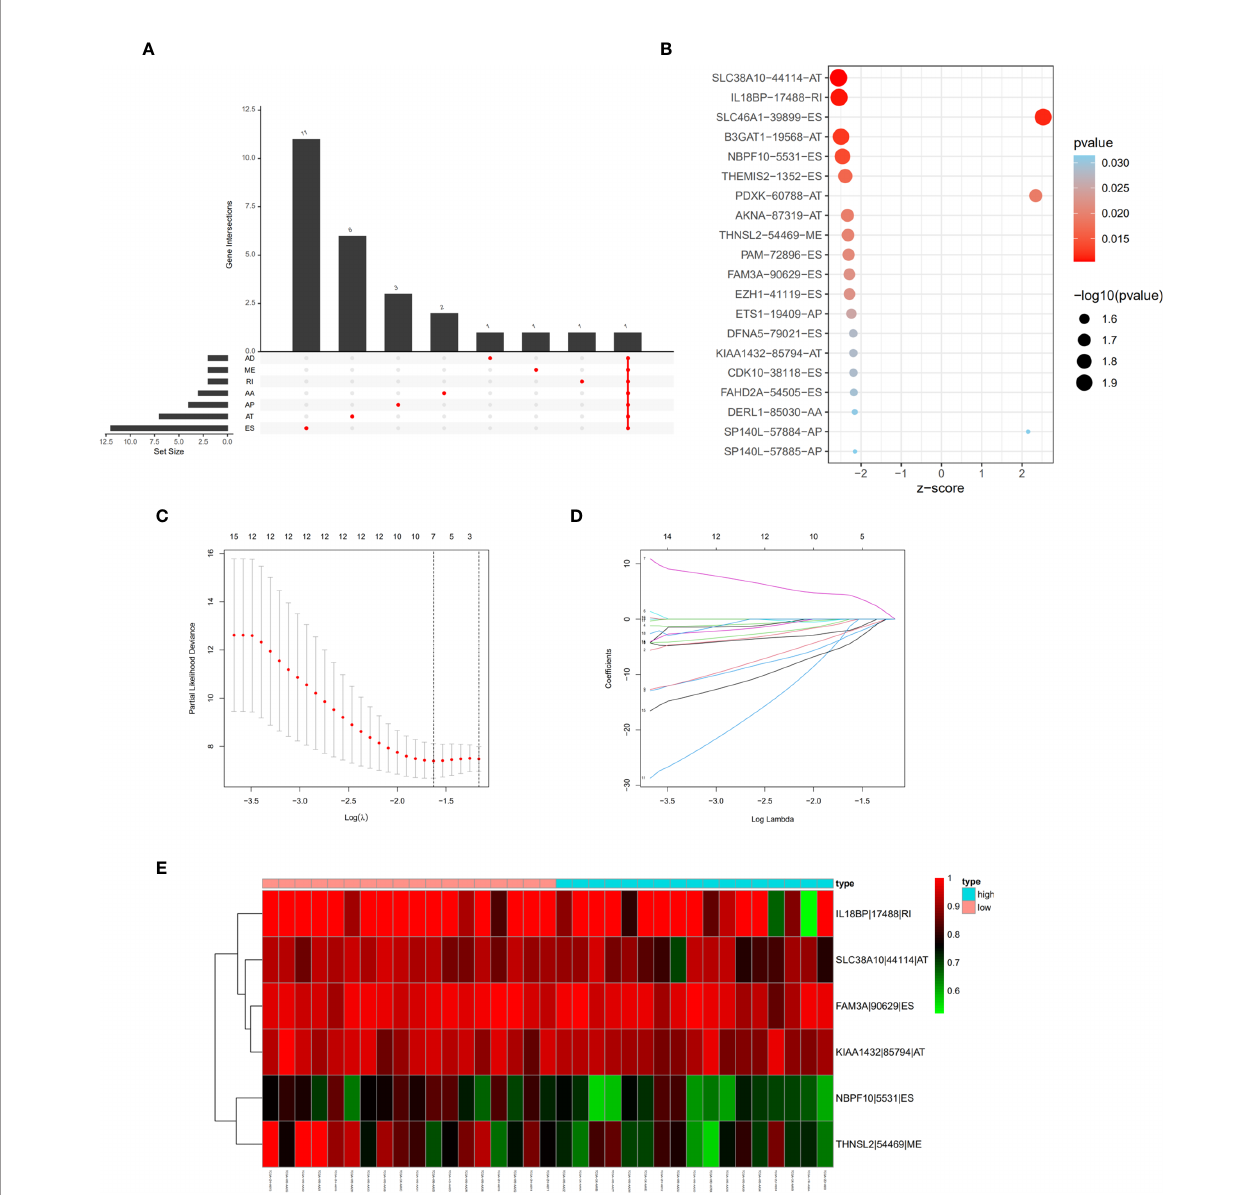
FIGURE 3 | Prognostic signature construction based on differential alternative splicing (AS) events between genomic stable (GS-like) and unstable (GU-like) groups. (A) Overall survival related AS events in patients with cholangiocarcinoma distinguished by alternate acceptor (AA), alternate donor (AD), alternate promoter (AP), alternate termination (AT), exon skipping (ES), mutually exclusive exon (ME), and retained intron (RI) splicing mode. (B) Bubble graph of overall survival related AS events in cholangiocarcinoma with P values and z-scores. (C, D) cvFit and lambda graph of the lasso regression model. (E) Heat map showed the expression of AS events enrolled in our prognosis model.